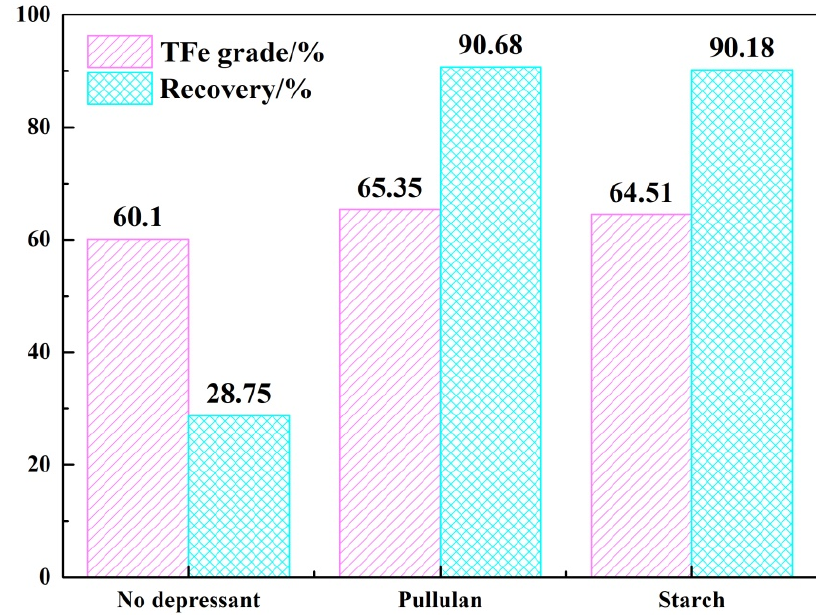
Figure 6. The results of mineral mixture tests.